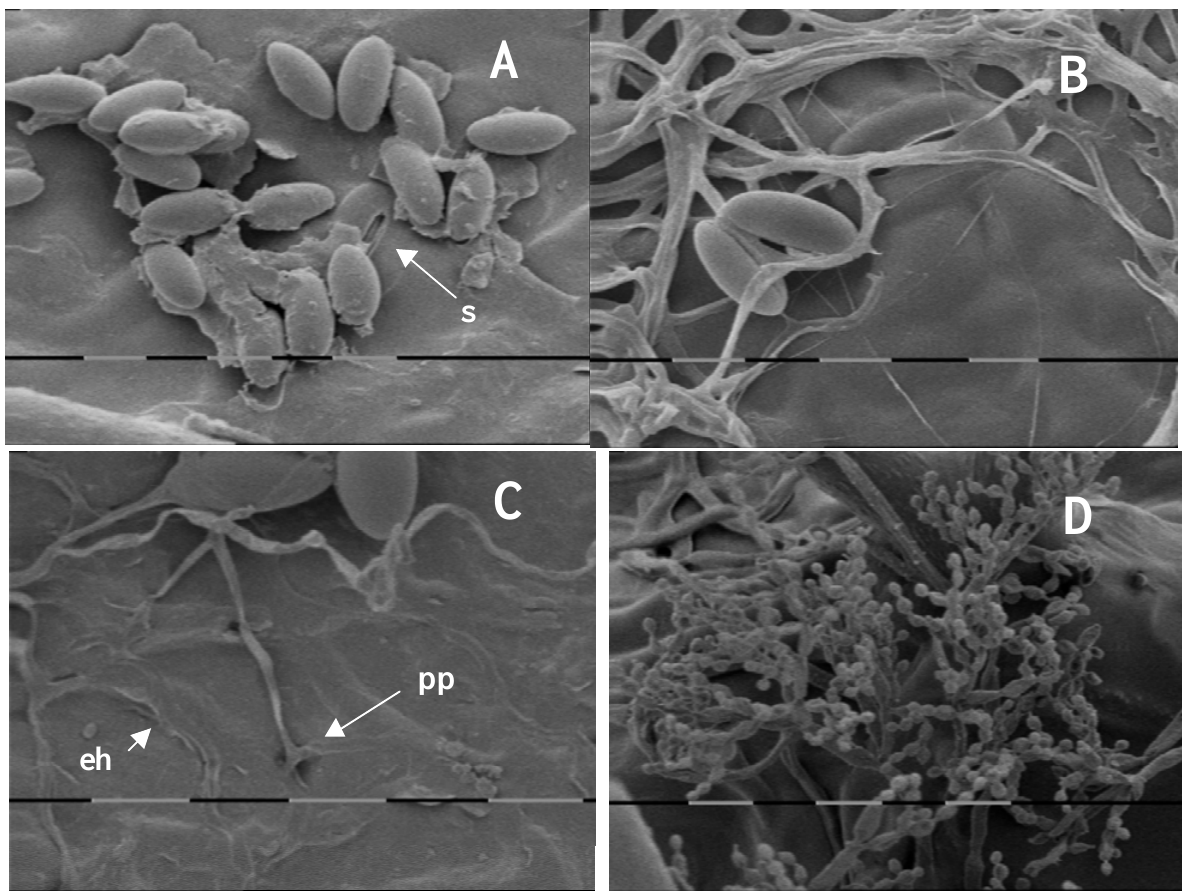
FIGURE 3. Quercus cerris leaves sprayed with a suspension of B. mediterranea ascospores. Control leaf: A, ungerminated spores (S = stoma) (abaxial blade). Ozone-exposed leaf (110 ppb O 3 , 5 h day –1 , 30 days): B, germinating spores and hyphae development (abaxial blade); C, germinating spores and entry of an hypha through the cuticle (pp = penetration point; eh, hypha embedded into the wax layer) (adaxial blade); D, anamorph of B. mediterranea (adaxial blade). White bar = 10 μ